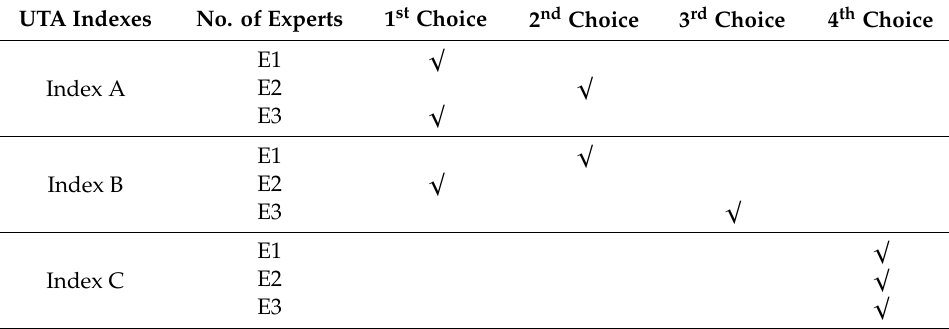
Table 2. Questionnaire survey of the importance of index